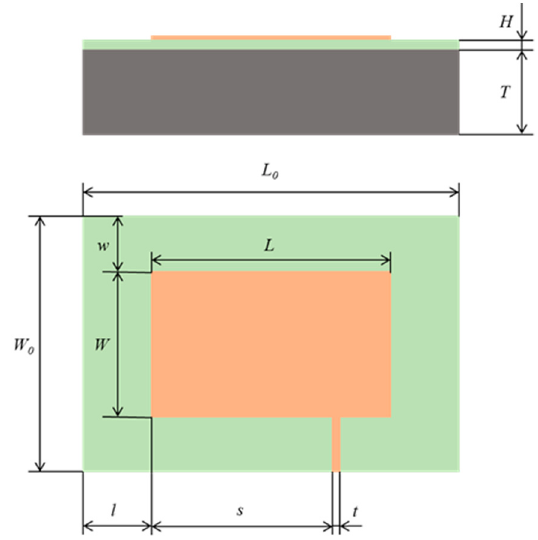
Figure 3. Dimension diagram of the patch antenna sensor.